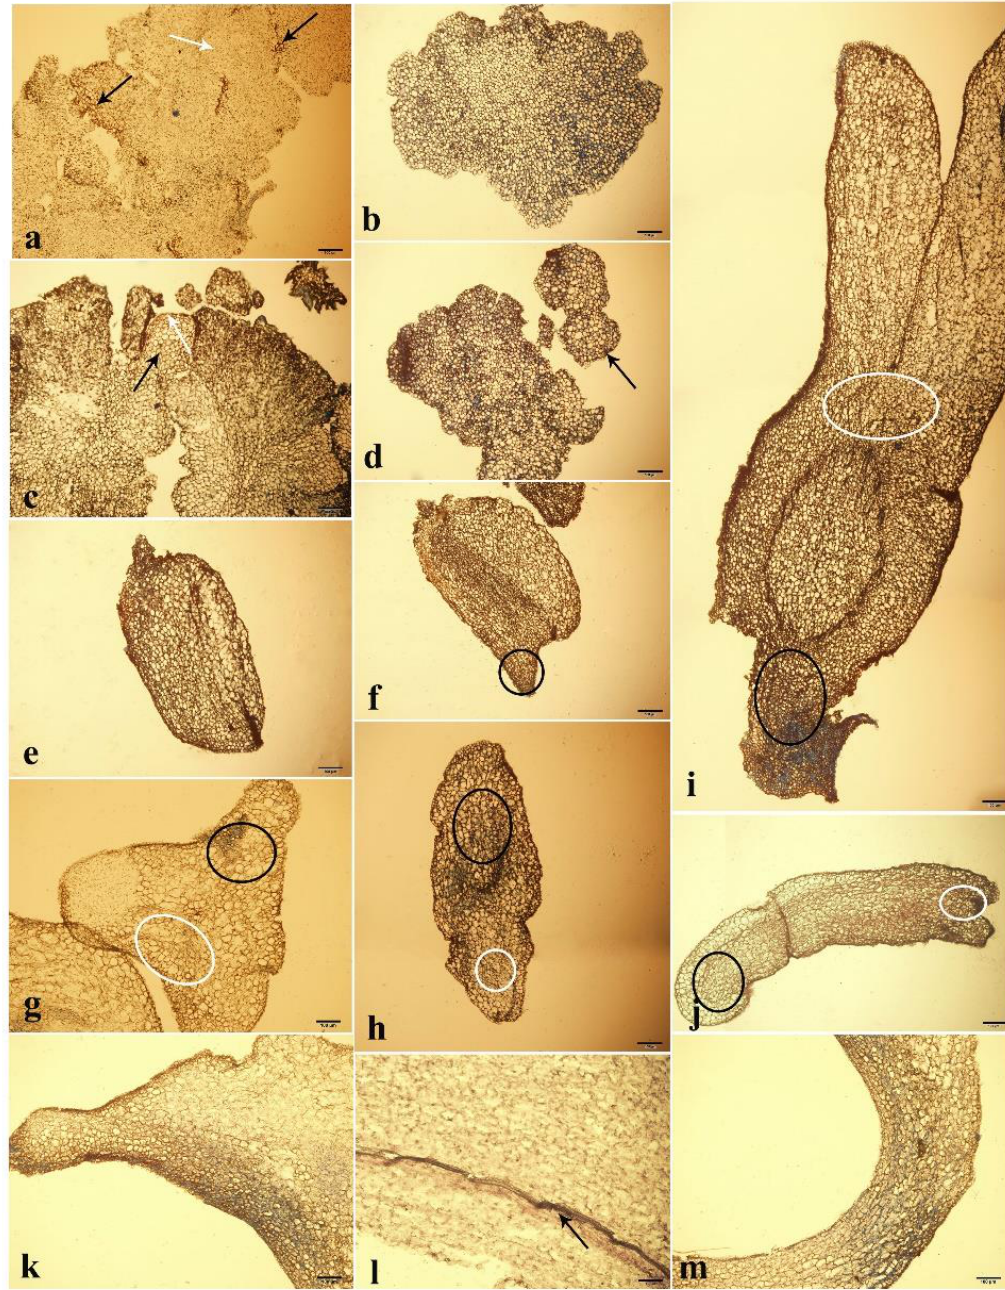
Figure 3. Various stages of somatic embryo induction and development in K. paniculata . a Procambia (black arrow in ( a ) in non-embryogenic calluses (white arrow in a ). ( b ) Embryogenic calluses. ( c – d ) Globular embryos (black arrow in c and d ) separated from calluses, protoderm (white arrow in c ) formation in globular embryo. ( e ) Kidney-shaped embryos. ( f ) Root meristem (black circle in f ) in monocotyledonous embryo. ( g ) Shoot apical meristem (white circle in g ) and root meristem (black circle in g ) in heart-shaped embryo. ( h ), ( j ) Shoot apical meristem (white circle in h , j ) and root meristem (black circle in h , j ) in torpedo-shaped embryos. ( i ) Shoot apical meristem (white circle in i ) and root meristem (black circle in i ) in cotyledon embryo. ( k ) Cotyledon longitudinal section in mature cotyledon embryo. ( l ) Vascular tissue (black arrow in l ) in mature cotyledon embryo. ( m ) Hypocotyl longitudinal section in mature cotyledon embryo. Scale bar: a – k , m = 100 µ m; l = 50 µ